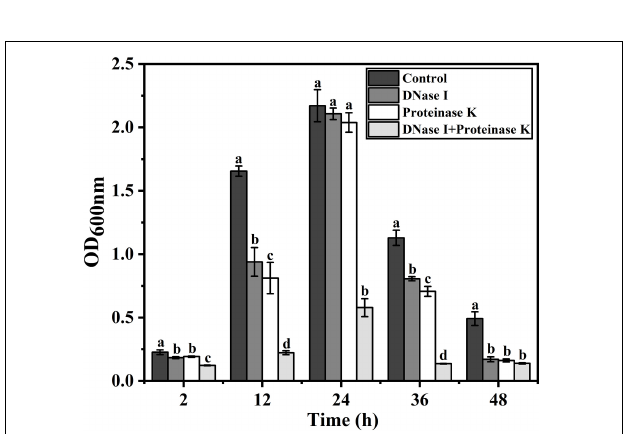
FIGURE 3 | Correlation analysis between eDNA, extracellular proteins, and carbohydrates of EPS in biofilm development of V. parahaemolyticus . (A) eDNA and extracellular proteins, (B) eDNA and carbohydrates, and (C) carbohydrates and extracellular proteins.